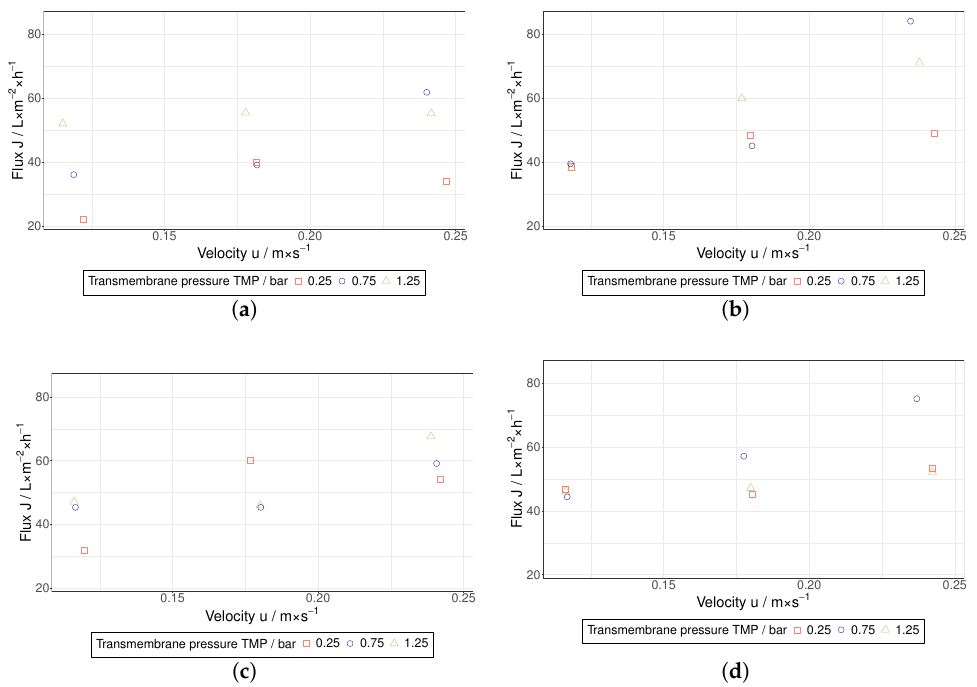
Figure 8. Stationary flux of the TFF treatment of HIV VLPs over the velocity for the different MWCOs; ( a ) 100kDa, ( b ) 300kDa, ( c ) 500kDa, ( d )